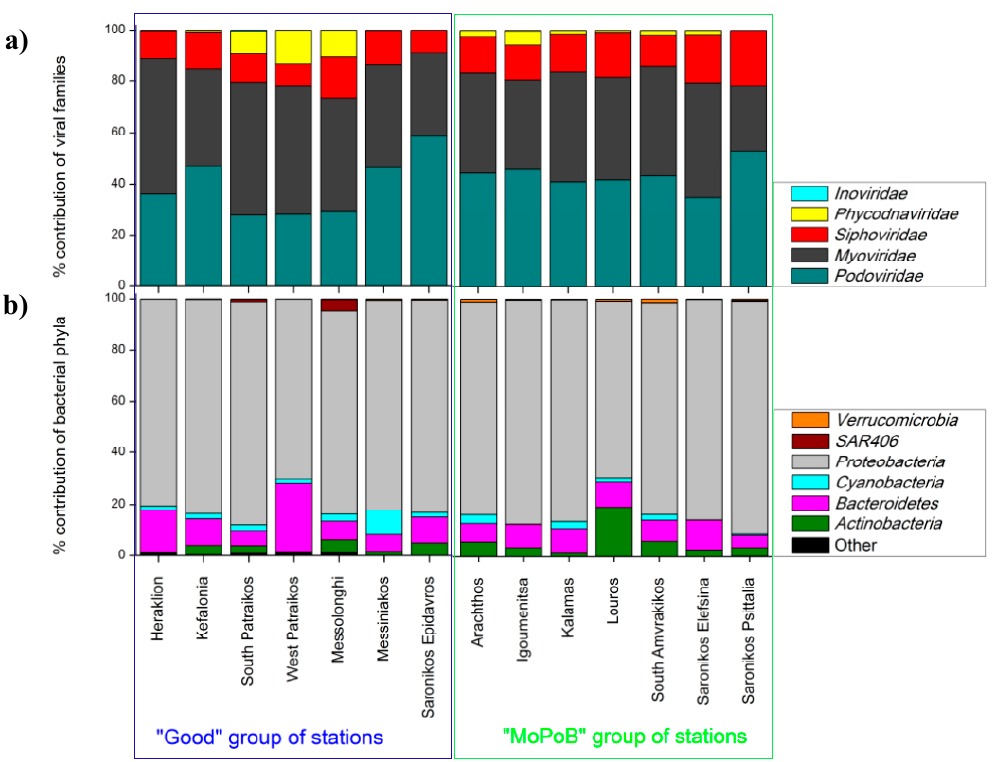
Figure 2. Viral and bacterial community profiles. ( a ) Viral community composition at the family level. ( b ) Bacterial community composition at the phylum level. “Other” bacterial phyla include: Acidobacteria , Armatimonadetes , Chlamydiae , Chlorobi , Chloroflexi , Firmicutes , Fusobacteria , GN02 , Gemmatimonadetes , Kazan-3B-2B , Lentisphaerae , Nitrospirae , OD1 , OP11 , OP3 , SAR406 , SBR1093 , SR1 , Spirochaetes , TM6 , TM7 , Tenericutes , Verrucomicrobia , WPS-2 , WS3 , and ZB3 . Samples are divided in two groups based on the ecological quality, i.e. the annual TRIX range (left: stations having Good ecological quality, and right: stations having Moderate–Poor–Bad ecological quality).